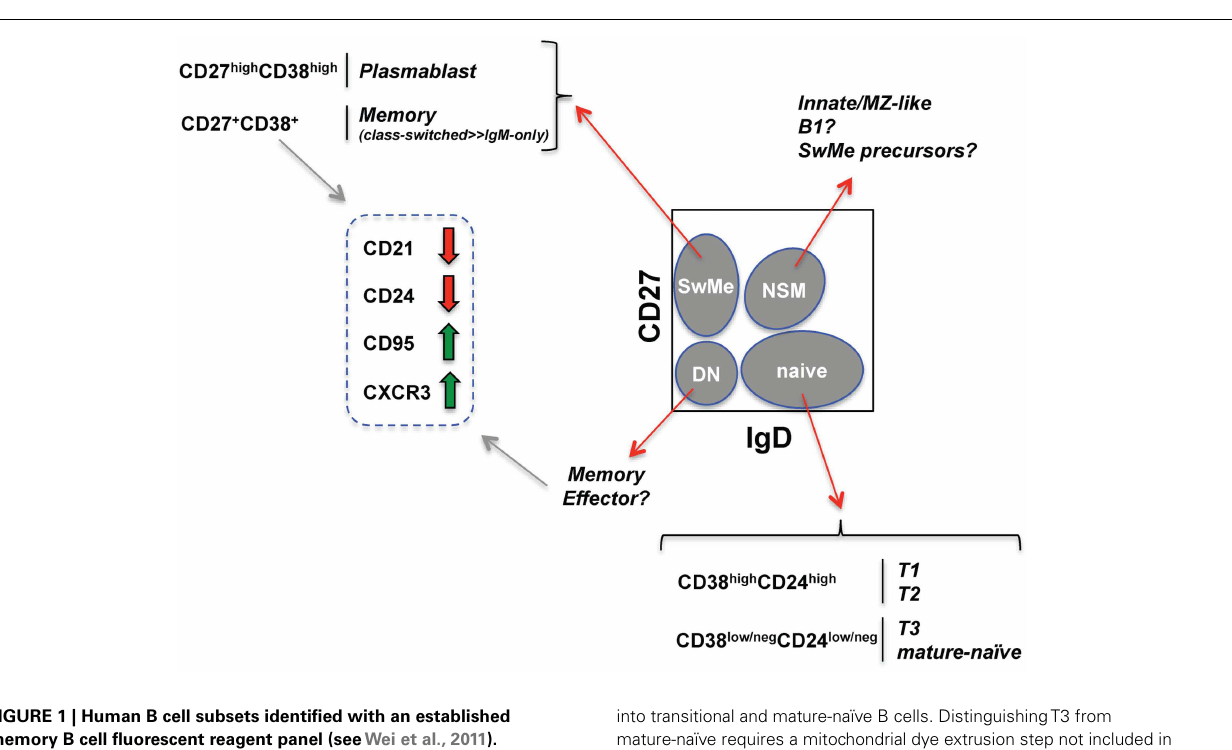
FIGURE 1 | Human B cell subsets identified with an established memory B cell fluorescent reagent panel (seeWei et al., 2011). Schematized flow cytometry plot (gated on viable PBMC CD19 + B cells) indicates four core B cell subsets ( gray ovals) defined by CD27 and IgD expression. SwMe, switched memory; DN, double-negative; NSM, non-switched memory.The naïve core subset can be further subdivided